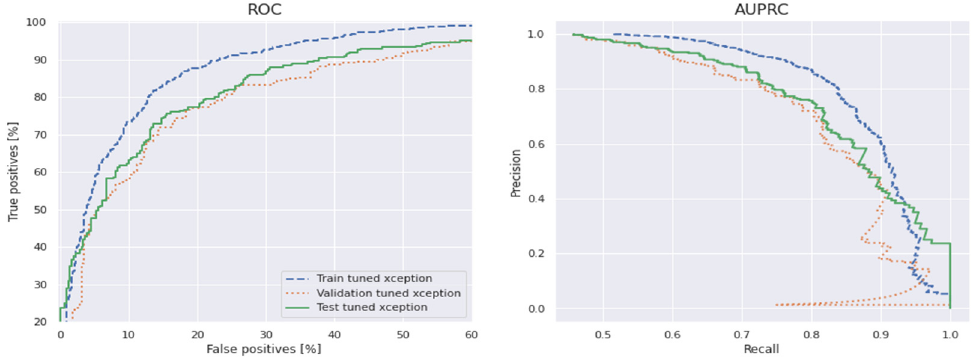
Figure 10. The comparisons of different CNN-based pretrained models with the proposed CVT- Trans technique for classification of five categories of cardiovascular disease. ( a ) Testing/Validation/Training loss, ( b ) Performance measures, ( c ) Computation time.